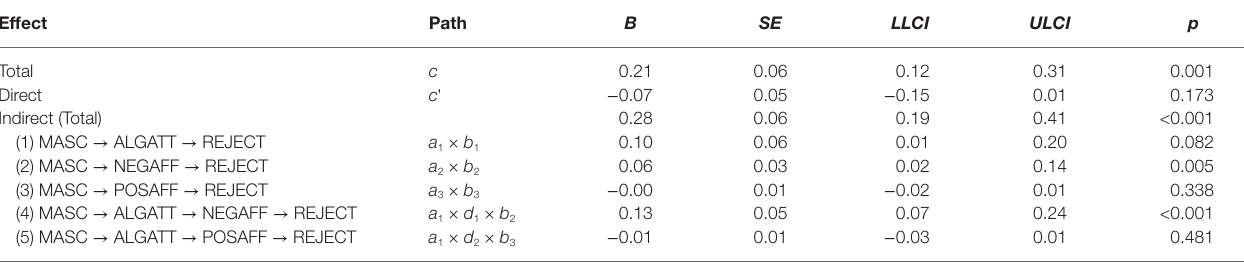
TABLE 2 | Path coefficients for the mediation model.